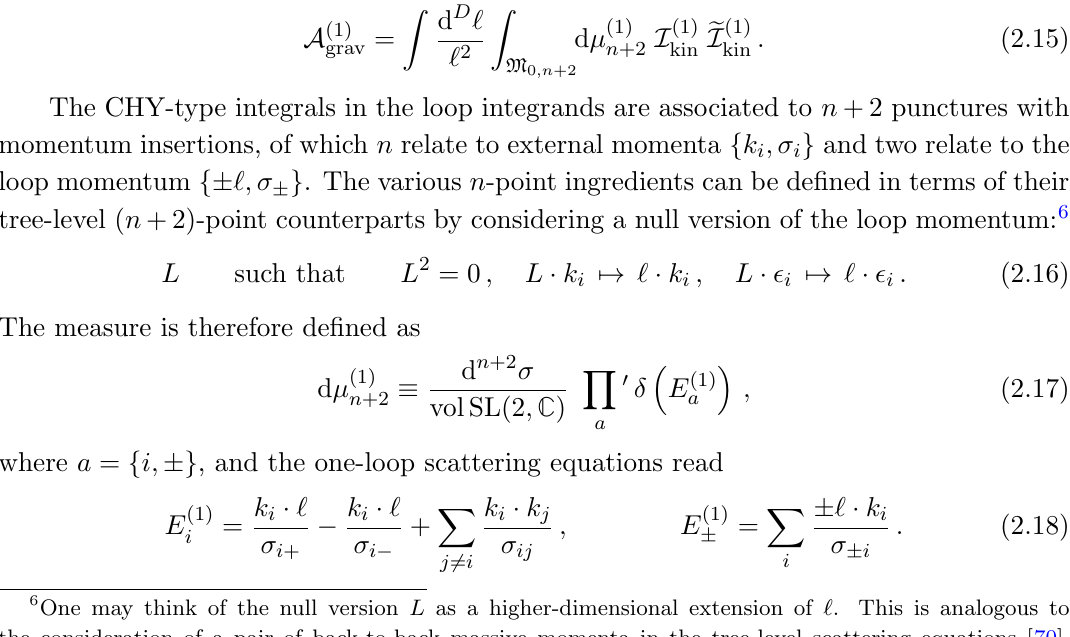
FIG. 1. Contour argument in the fundamental domain.